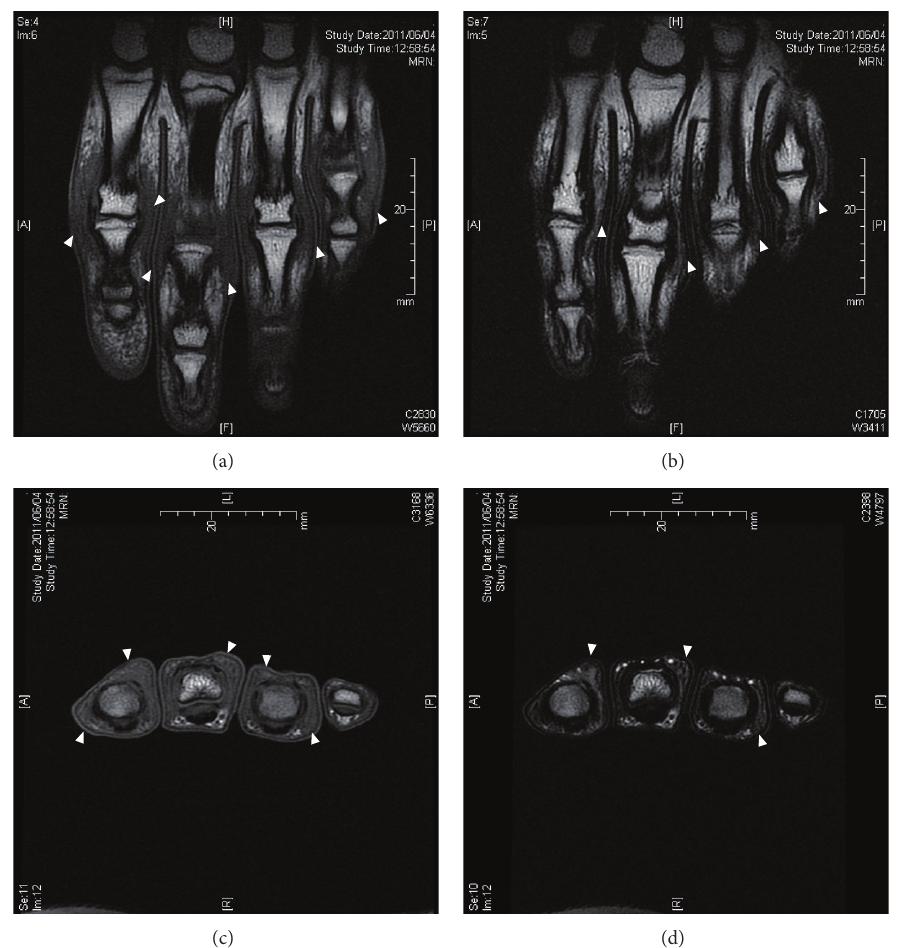
Figure 3: Coronal (a, b) and axial (c, d) views of magnetic resonance imaging of the left hand. Homogeneous low-intensity subcutaneous lesion around the PIP joints (arrow heads) on T1-weighted image (a, c) and T2-weighted image (b,